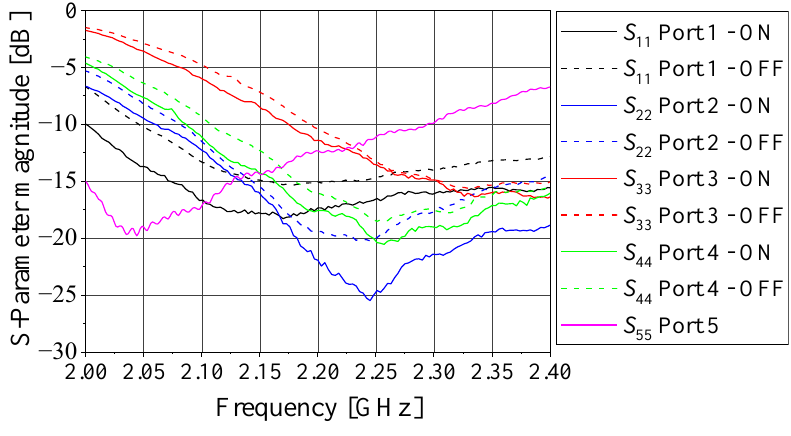
Figure 10. Magnitude of reflection coefficients 𝑆 𝑗𝑗 .